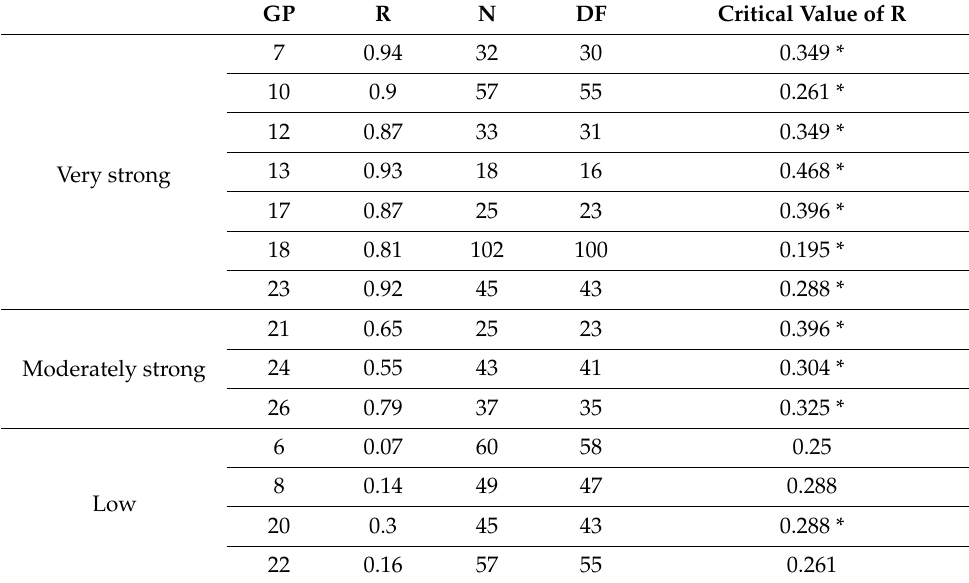
Table 4. Report of Pearson correlation values (R) for TC-GSC-genomic profiles comparison. GPs are ranked into three groups: ones with a very strong correlation between the pair of genomic profiles (R ≥ 0.80); ones with a moderately strong correlation (0.40 ≤ R < 0.80); ones with a low correlation (R < 0.40). The statistical significance for each pair of correlations was calculated consulting the Table of Critical Values for Pearson’s R. N: total number of CNAs; DF: degree of freedom (N-2). Level of significance for a two-tailed test α = 0.05. * indicates statistically significant test. GP